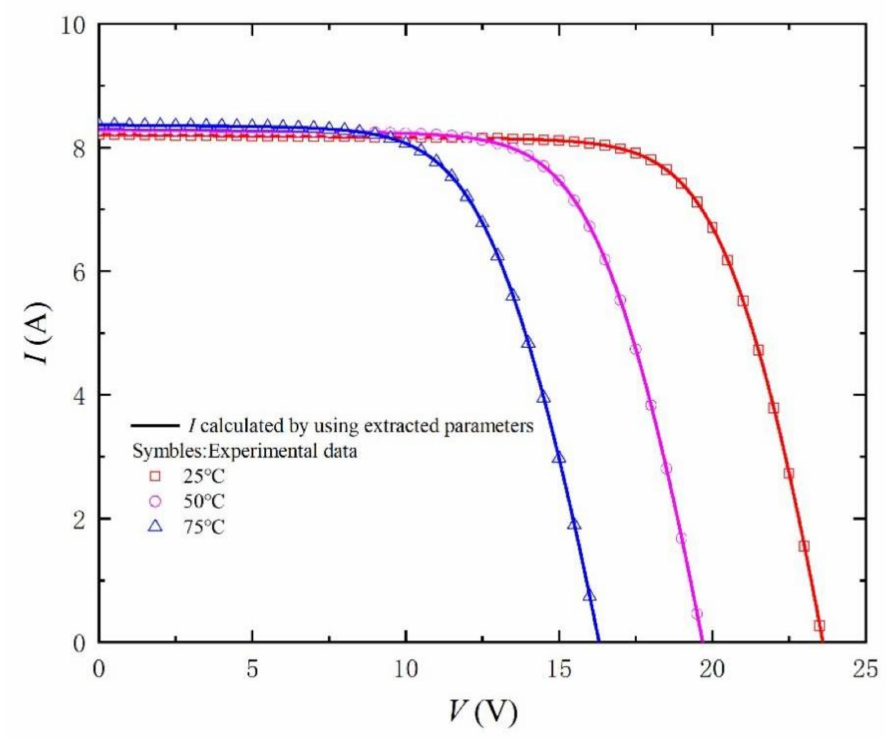
Figure 12. I-V curves measured from experimental data [33] at G = 1000 W/m 2 and different temperatures, and calculated by using the extracted parameters listed in Table